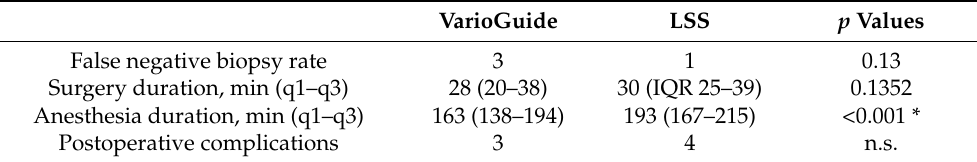
Table 2. Outcome comparison.